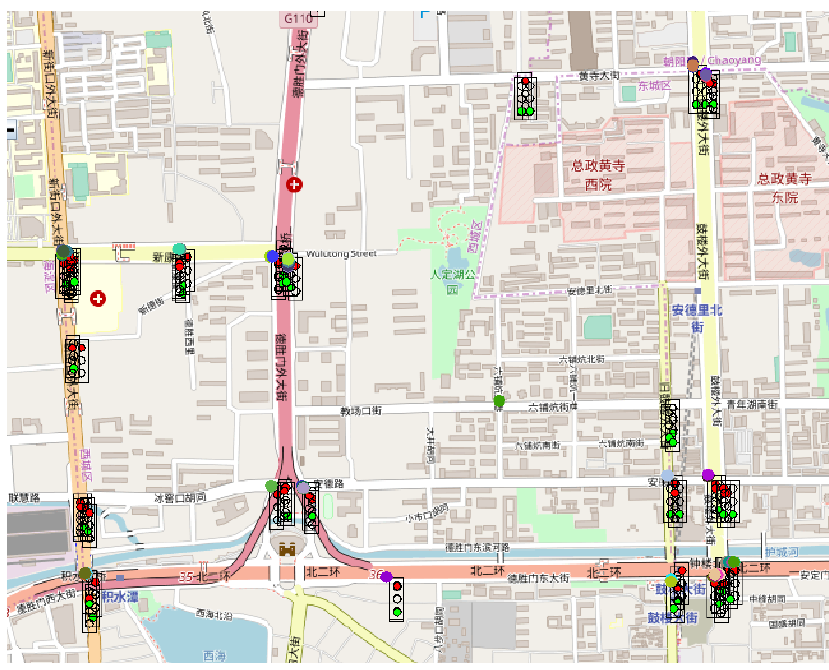
Figure 15. Sim2Car screenshot for traffic conditions in